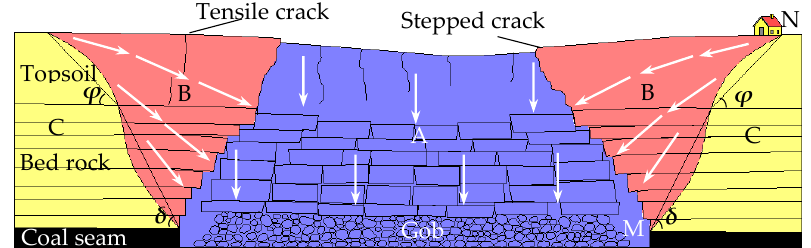
Figure 3. Horizontal zoning of overlying strata movement above the gob.